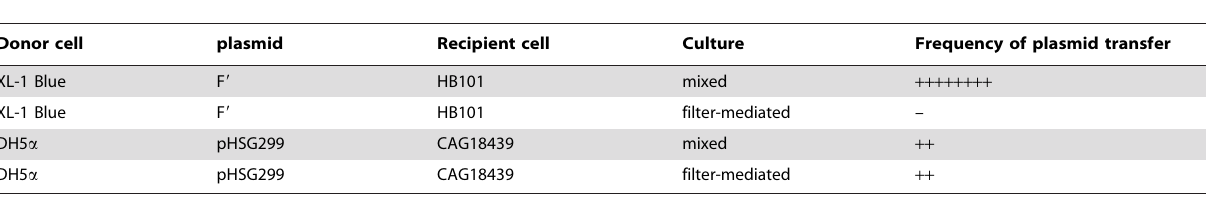
Table 4. Lateral plasmid transfer through nylon membrane filter in colony biofilm culture.